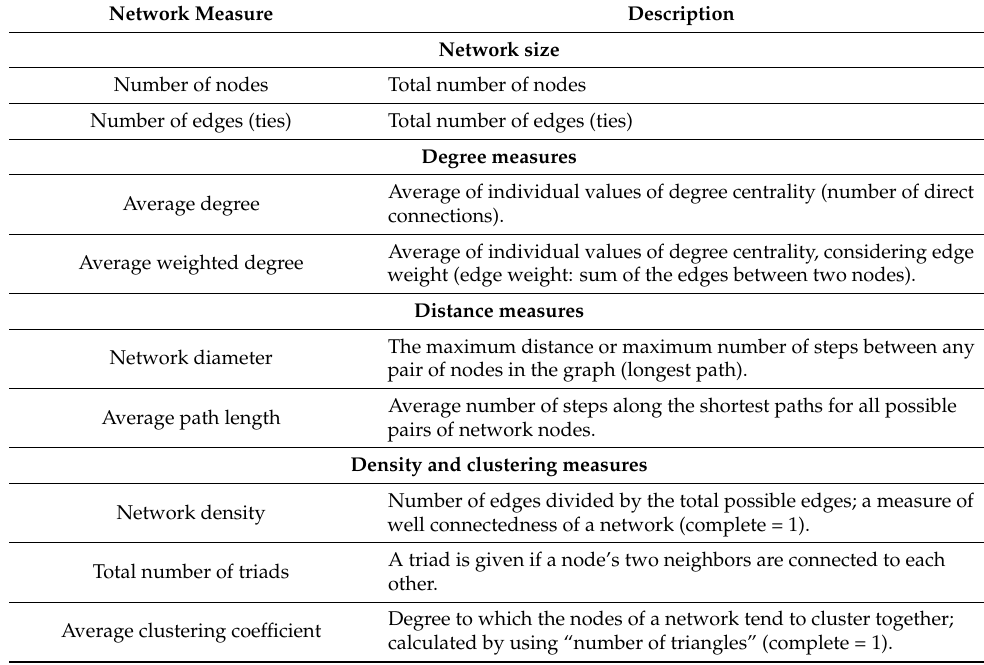
Table 3. Calculated global network measures (see